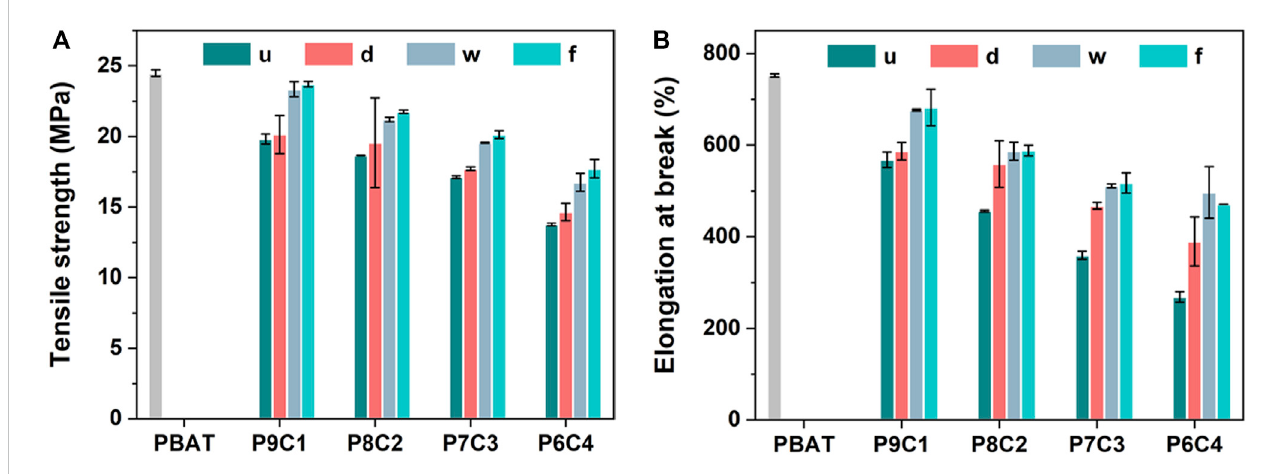
FIGURE 5 (A) Tensile strength and (B) elongation at break of PBAT composites fi lled with different content and modi fi cation method of CaCO 3 .